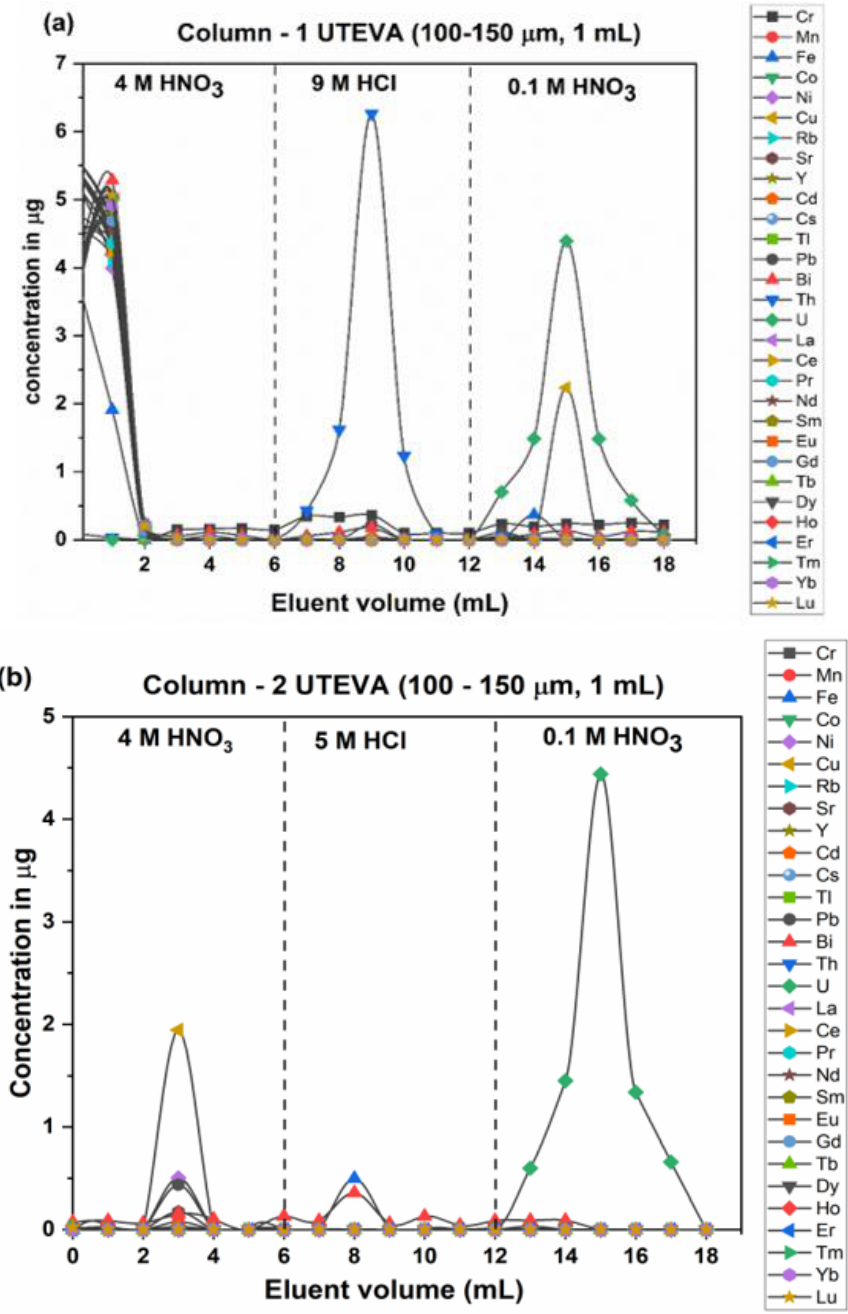
Figure 2. ( a ). Elution curves of U separation using first UTEVA columns; ( b ). Elution curves of U separation using second UTEVA column.